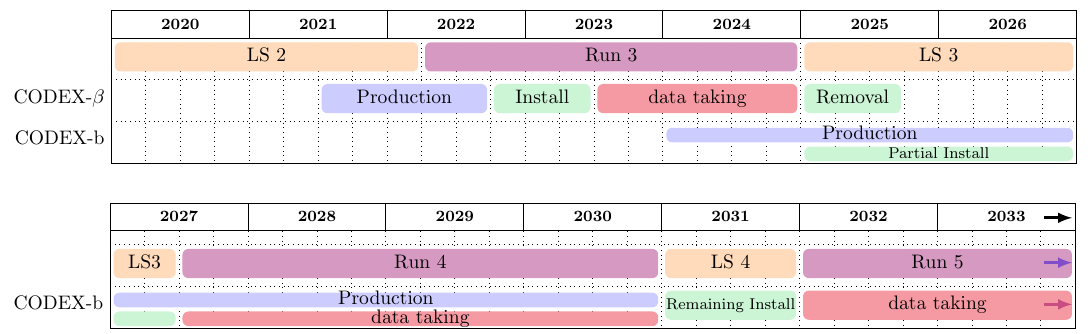
Fig. 1 Schematic summary of reach and coverage of current, planned or proposed experiments in terms of the LLP mass, lifetime and the required √ ˆ s parton center-of-mass energy,